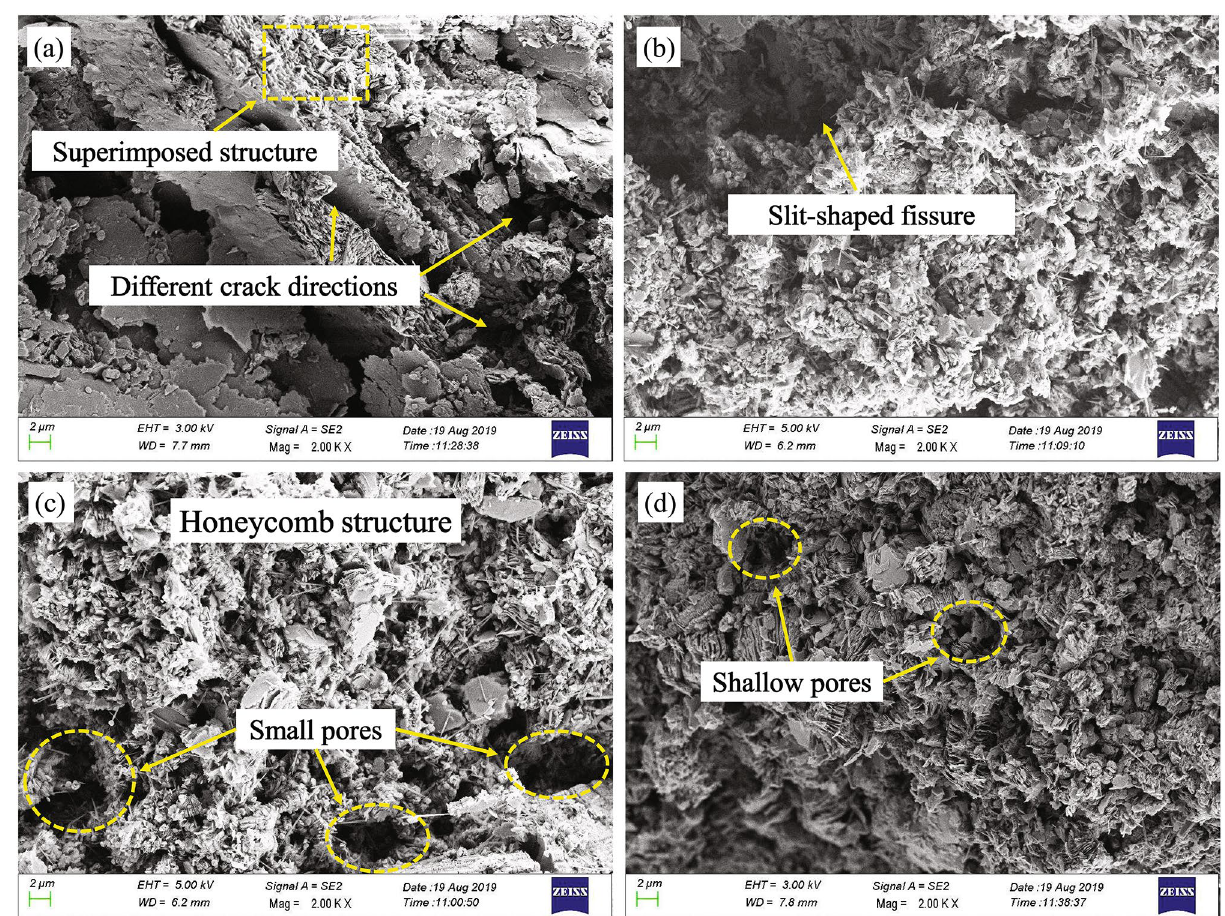
Figure 13. SEM images of soil samples under different consolidation stresses: ( a ) P = 12.5 kPa, ( b ) P = 100 kPa, ( c ) P = 400 kPa, ( d ) P = 1600 kPa.